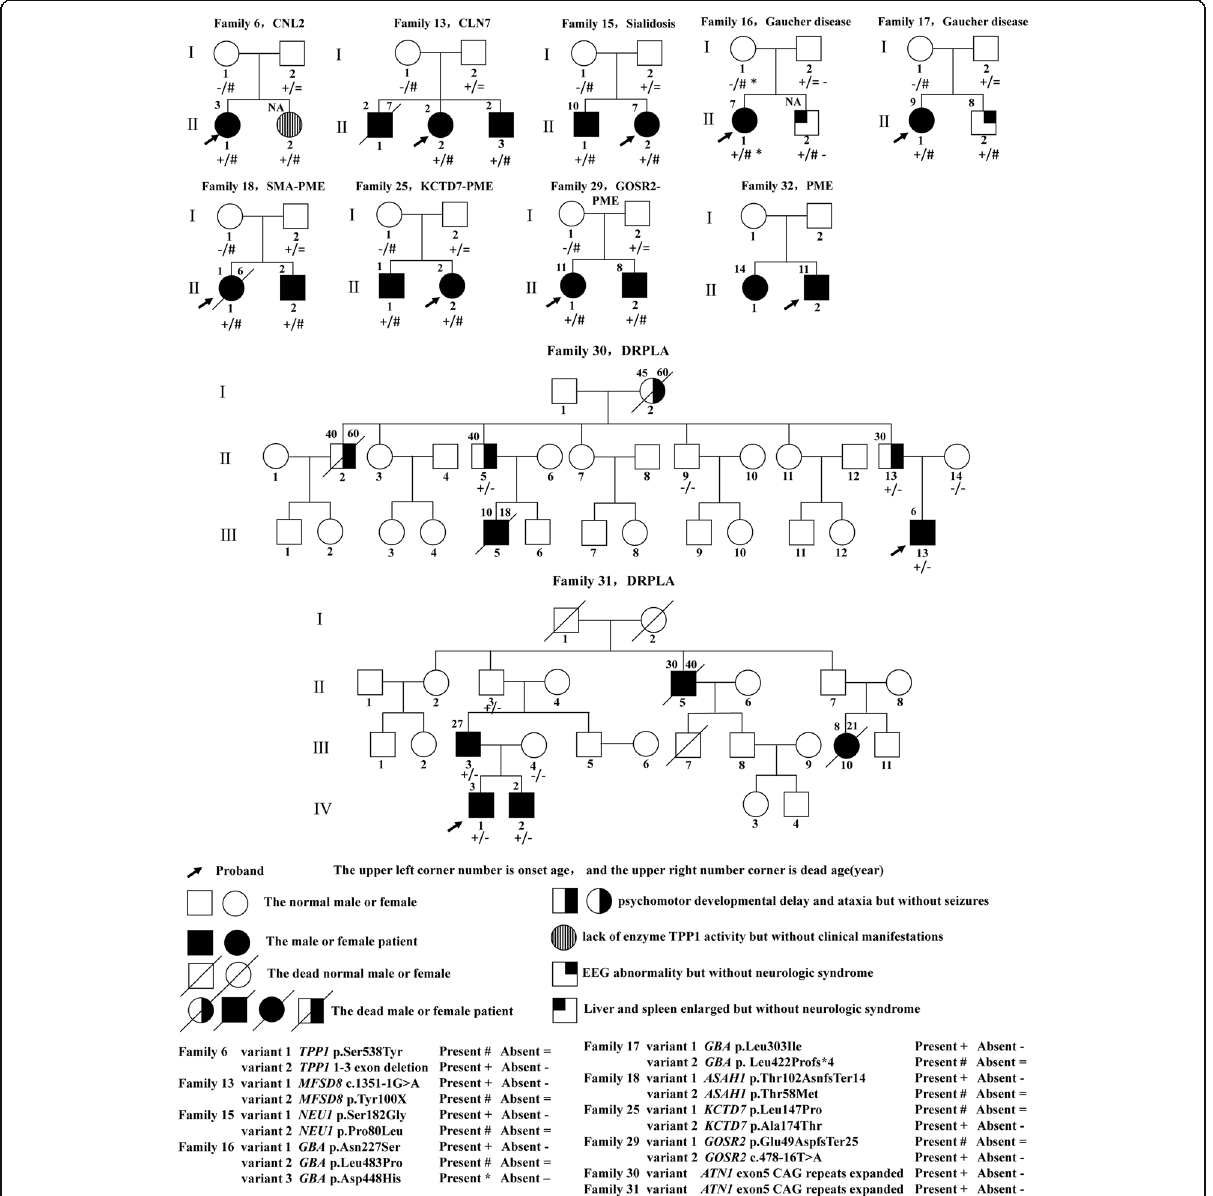
Fig. 1 The 11 family pedigrees of proband and other affected members. SMA-PME: spinal muscular atrophy-progressive myoclonic epilepsy; PME: progressive myoclonic epilepsy; DRPLA: dentatorubral-pallidoluysian atrophy; TPP1: lysosomal enzyme tripeptidy l peptidase; EEG: